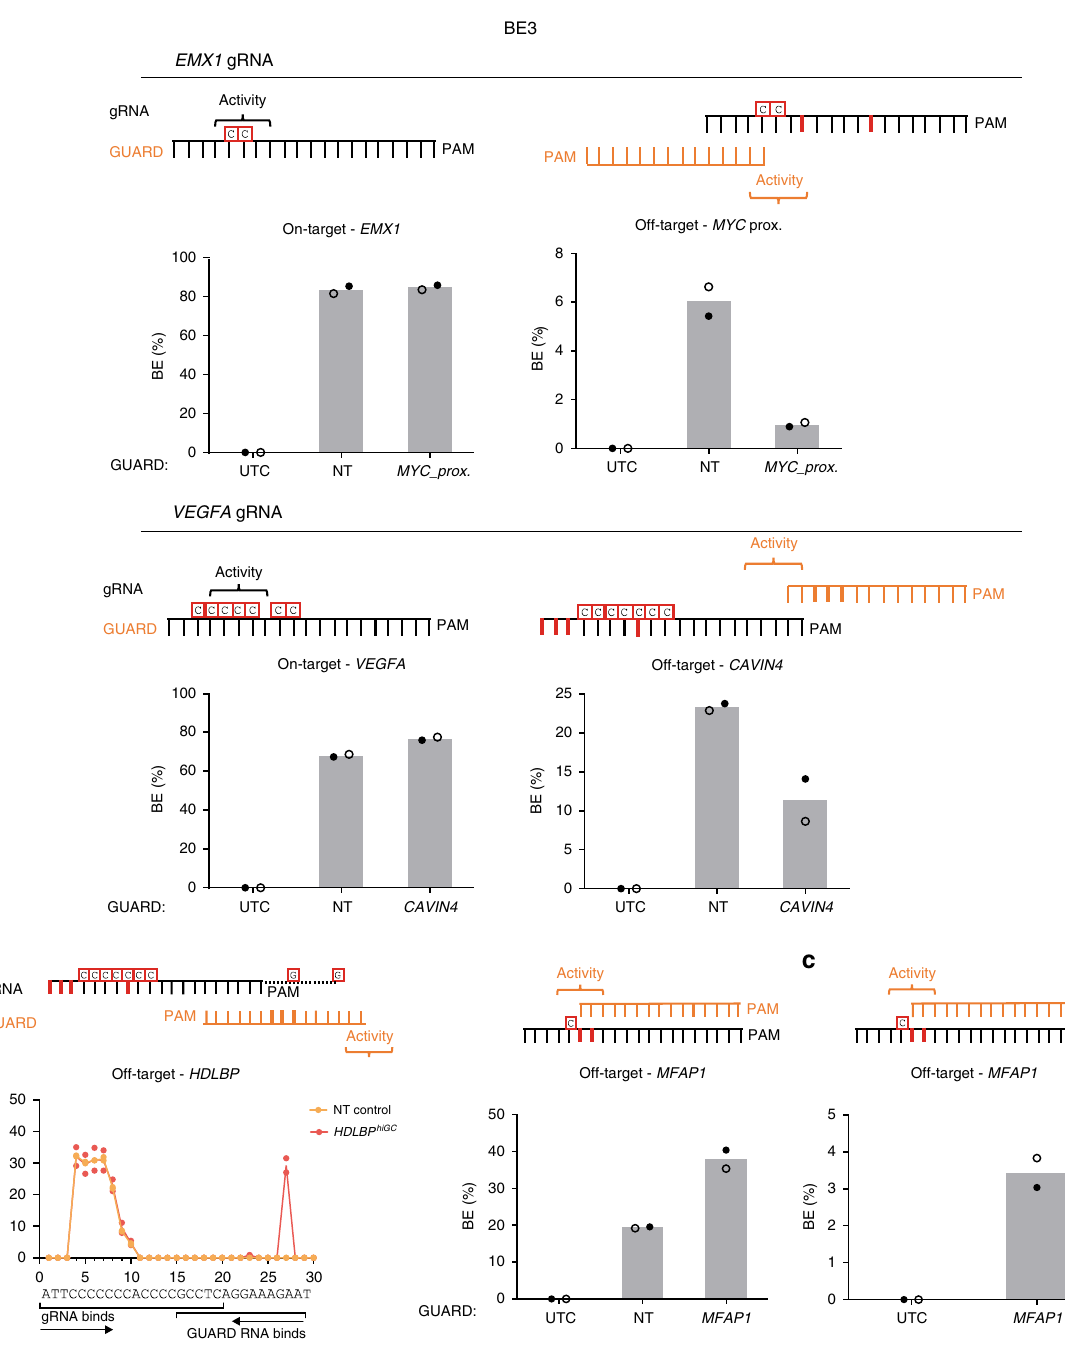
Fig. 4 GUARD RNAs can reduce off-target base editing if designed to avoid cytosine exposure. a Protection from off-target cytosine deamination with CRISPR GUARD. Base editing rates from amplicon sequencing of BE3-expressing HEK293 cells transfected with EMX1 or VEGFA on-target gRNA (25 nM) and the indicated GUARD RNA (125nM). Shown is the cumulative editing rate for the cytosines highlighted. The predicted cytosine deamination activity window is indicated. b Increased base editing frequencies with GUARD RNAs that expose cytosines. Base editing rates from amplicon sequencing of BE3- expressing HEK293 cells transfected with EMX1 (left) or VEGFA (right) on-target gRNA (25 nM) and the indicated GUARD RNA (125 nM). c GUARD RNAs can facilitate base editing without full-length on-target gRNAs. Base editing rates from amplicon sequencing of BE3-expressing HEK293 cells transfected with MFAP1 GUARD RNA only (125 nM). Data represent the mean of two independent experiments with symbols representing each replicate. Source data are provided as a Source Data fi A high-throughput screen identi fi es functional GUARD RNAs . short GUARD RNAs are suf fi cient to independently support base editing in cells. It is likely that the low level of base editing observed with short GUARD RNAs alone is due to the lack of nickase activity, which is analogous to editing with base editor 2 versions 28 . given target, we adapted a high-throughput approach 30,31 using a